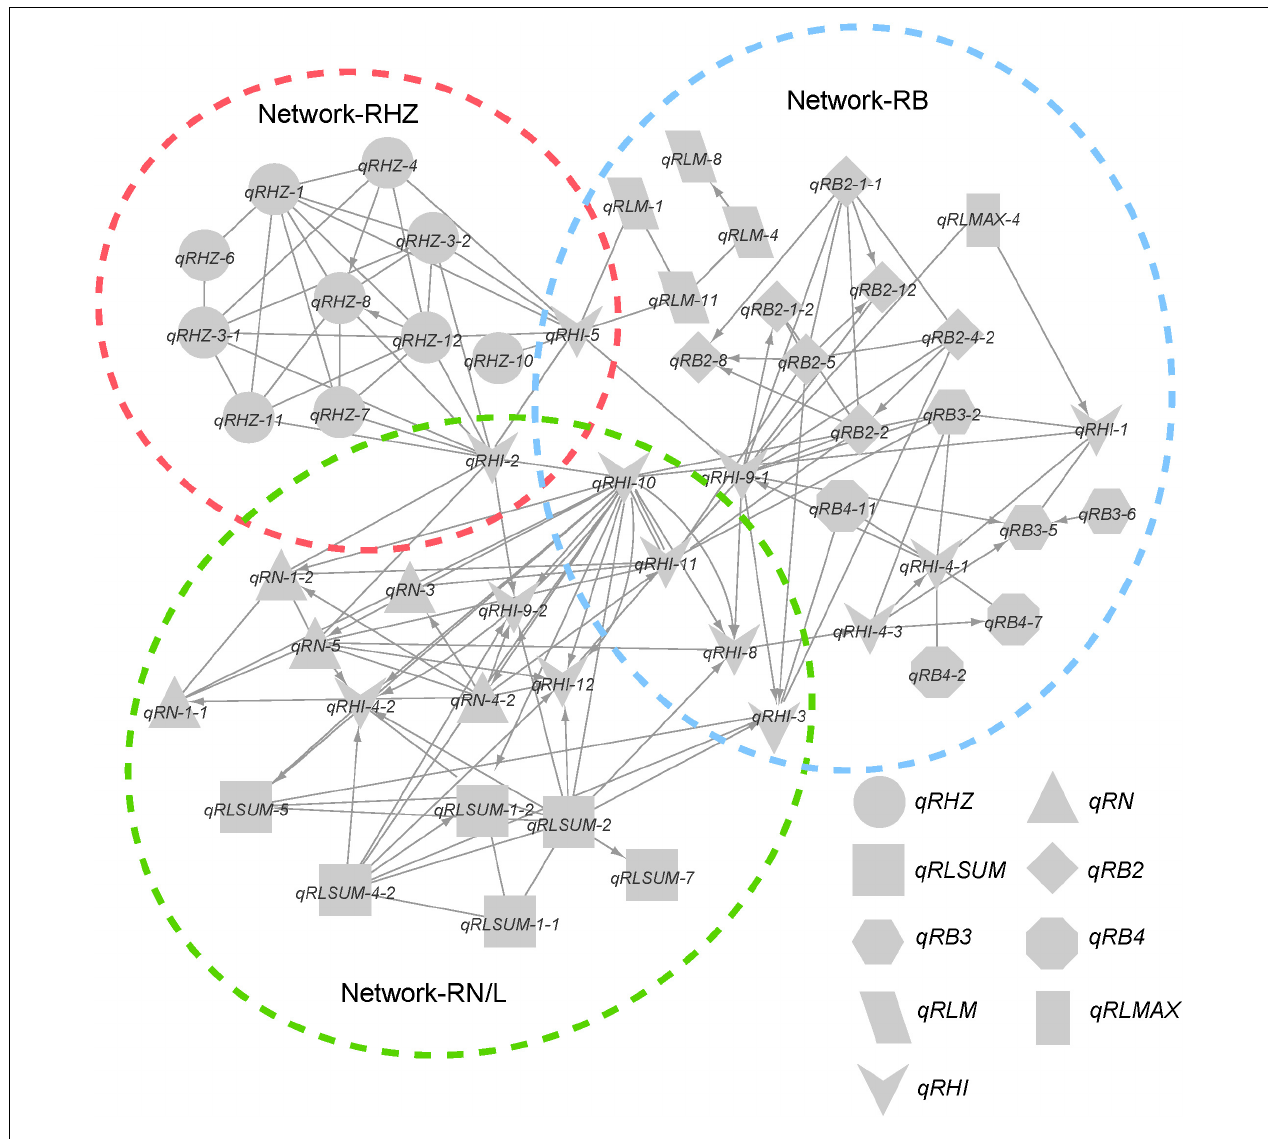
FIGURE 6 | Genetic network underlying rhizome